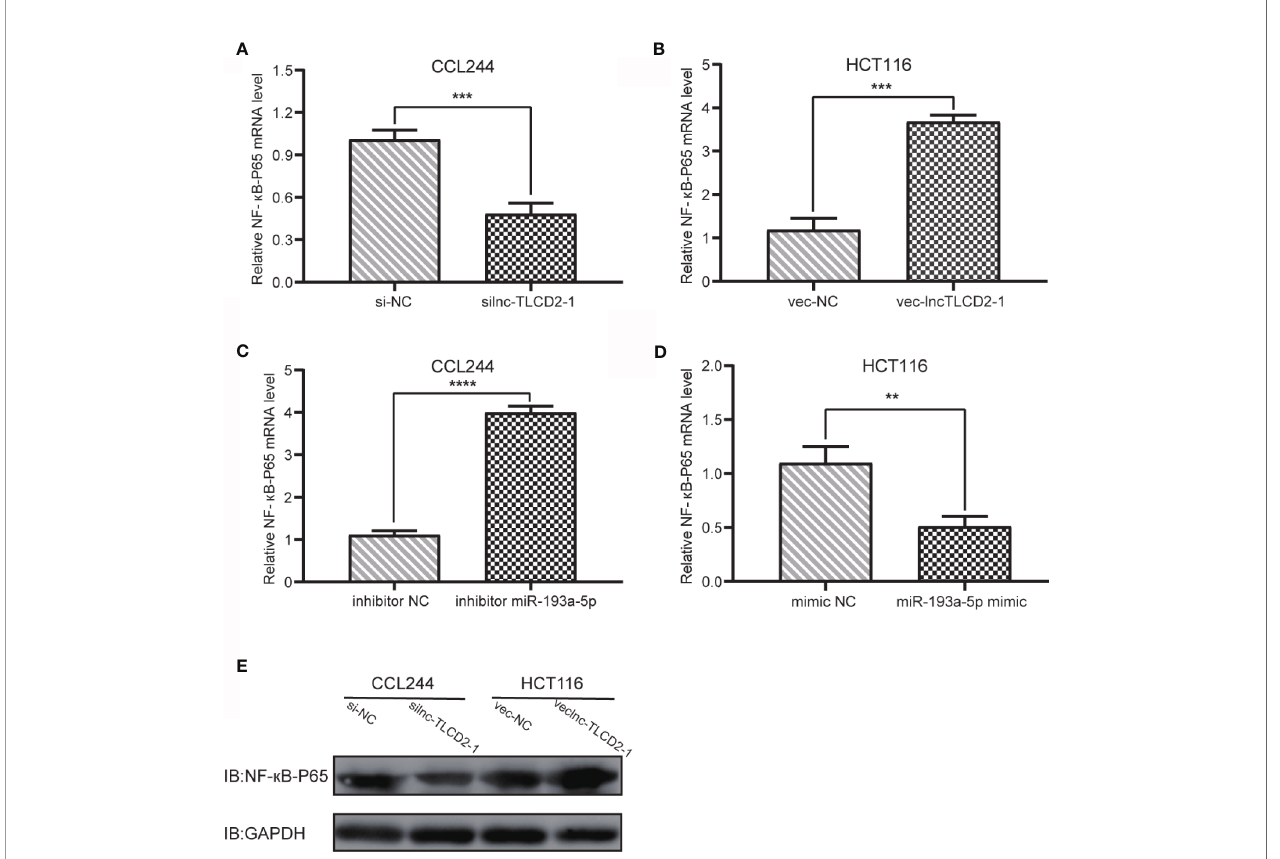
FIGURE 6 | Regulation of lnc-TLCD2-1 and hsa-miR-193a-5p on NF- к B-P65. (A) In CCL244, the expression of NF- к B-P65 decreased after interference of lnc- TLCD2-1. (B) The expression of NF- к B-P65 increased after overexpression of lnc-TLCD2-1 in HCT116. (C) NF- к B-P65 was increased after inhibition of miR-193a- 5p in CCL244. (D) NF- к B-P65 was down-regulated after upregulation of miR-193a-5p in HCT116. (E) Western Blot detected the change of NF- к B-P65 in protein level. (P<=0.05 means statistically signi fi cant, **p < 0.01, ***p < 0.001, ****p <